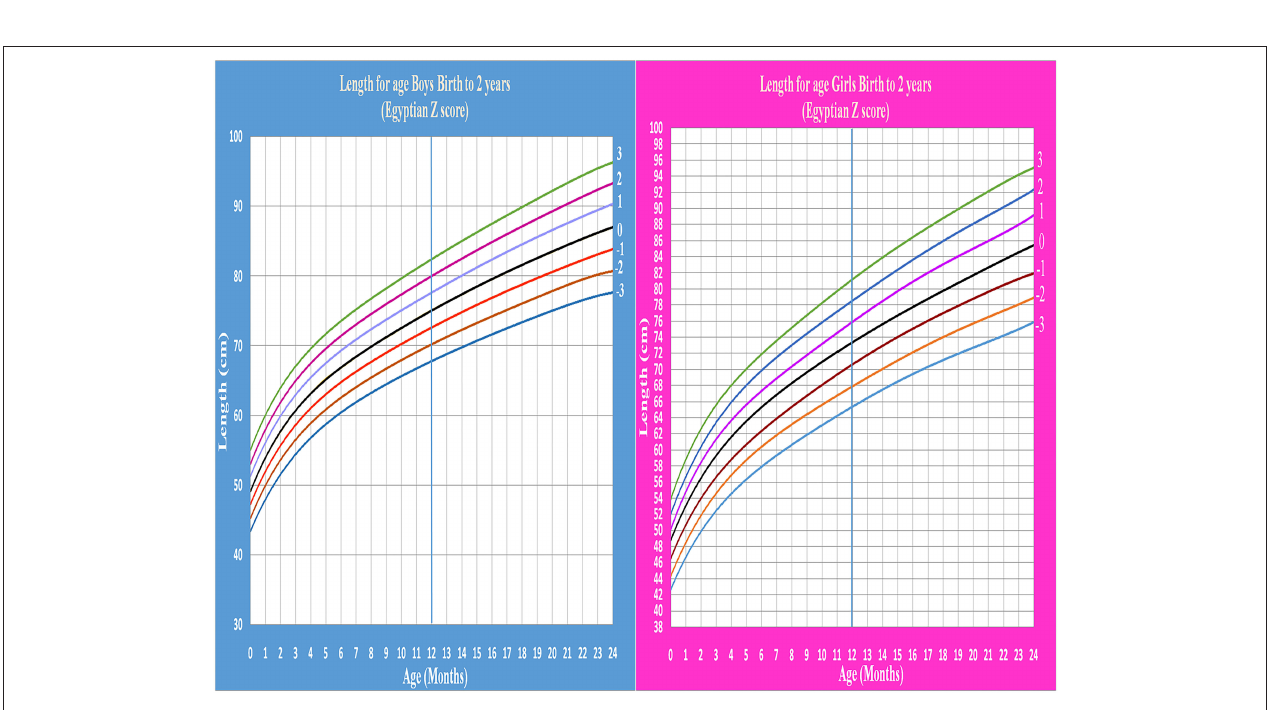
FIGURE 3 | Egyptian Z score length for age from birth to 2 years for boys &